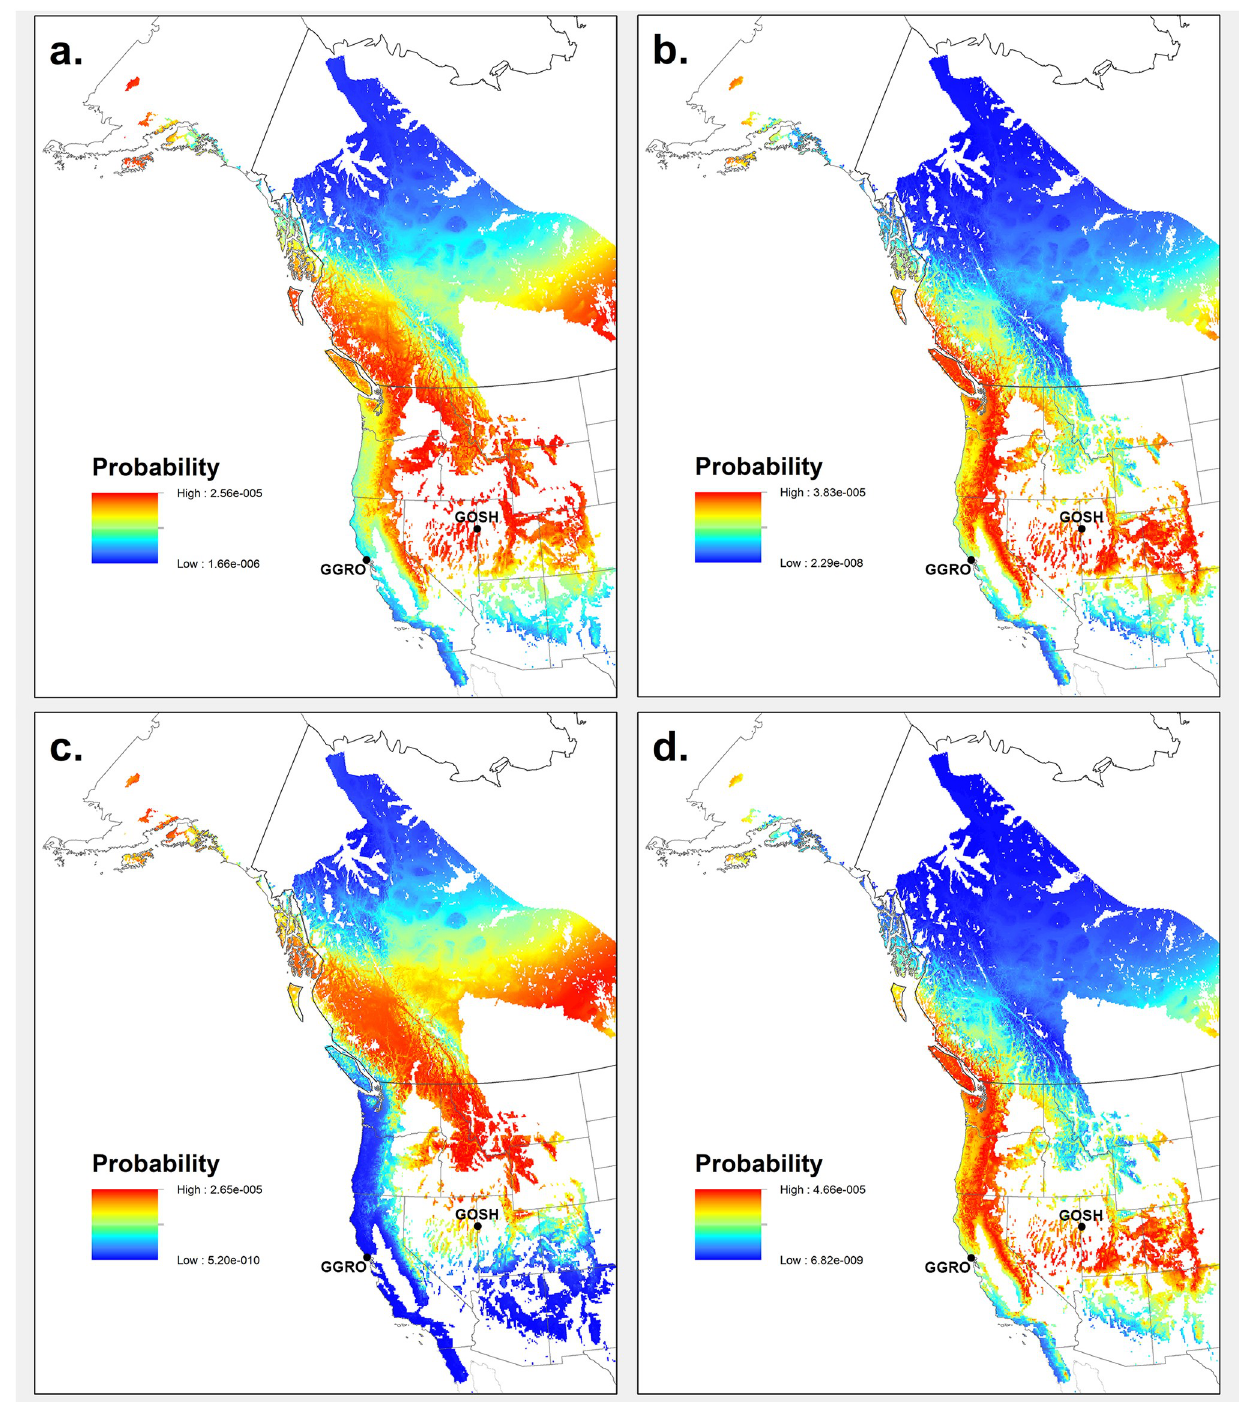
Fig 6. Probability density maps of the origin of migrating juvenile Sharp-shinned Hawks ( Accipiter striatus ). Maps are based on predicted δ 2 H P values (‰) (left panels) and predicted δ 18 O P values (‰) (right panels) for birds captured (a and b) along the Pacific Coast Flyway at the Golden Gate Raptor Observatory (GGRO) and (c and d) along the Intermountain Flyway at the Goshute Mountains HawkWatch (Goshutes). Each map represents the mean of probability density surfaces created for individual birds sampled at a location and by isotope group. Collection sites of migratory bird samples are indicated as GGRO (Golden Gate Raptor Observatory) and GOSH (Goshutes Mountains). State and country boundaries are from public domain GIS files US Census Bureau (2016) and Natural Earth (2020). Species range acquired with permission from BirdLife International and NatureServe (2015), and data to create the GIS biome layer acquired from Brown, Bennan, and Unmack